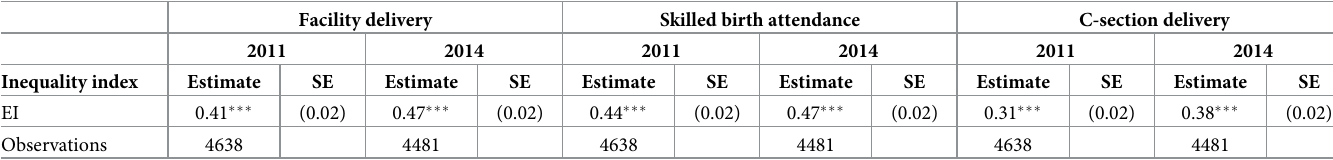
Table 3. Inequality in delivery care services in Bangladesh, 2011 and